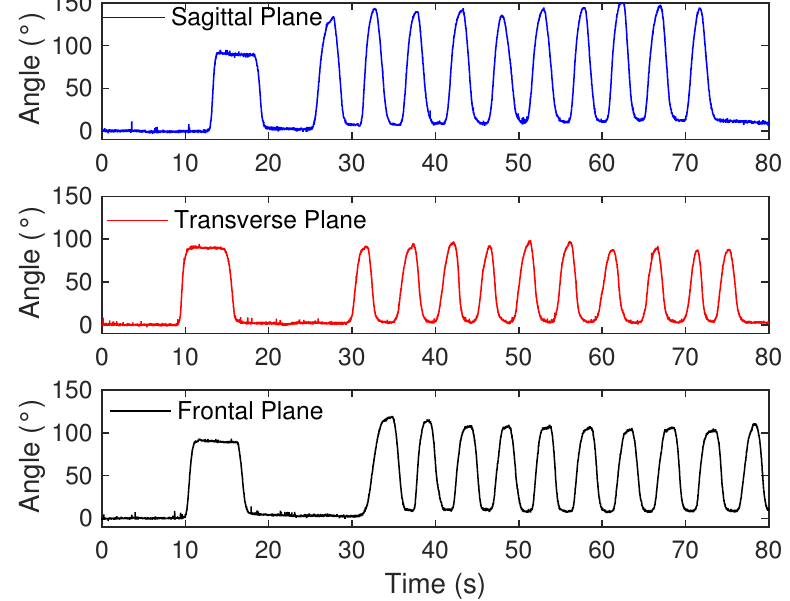
Figure 10. Sensors’ placement on the human upper limb and the movements